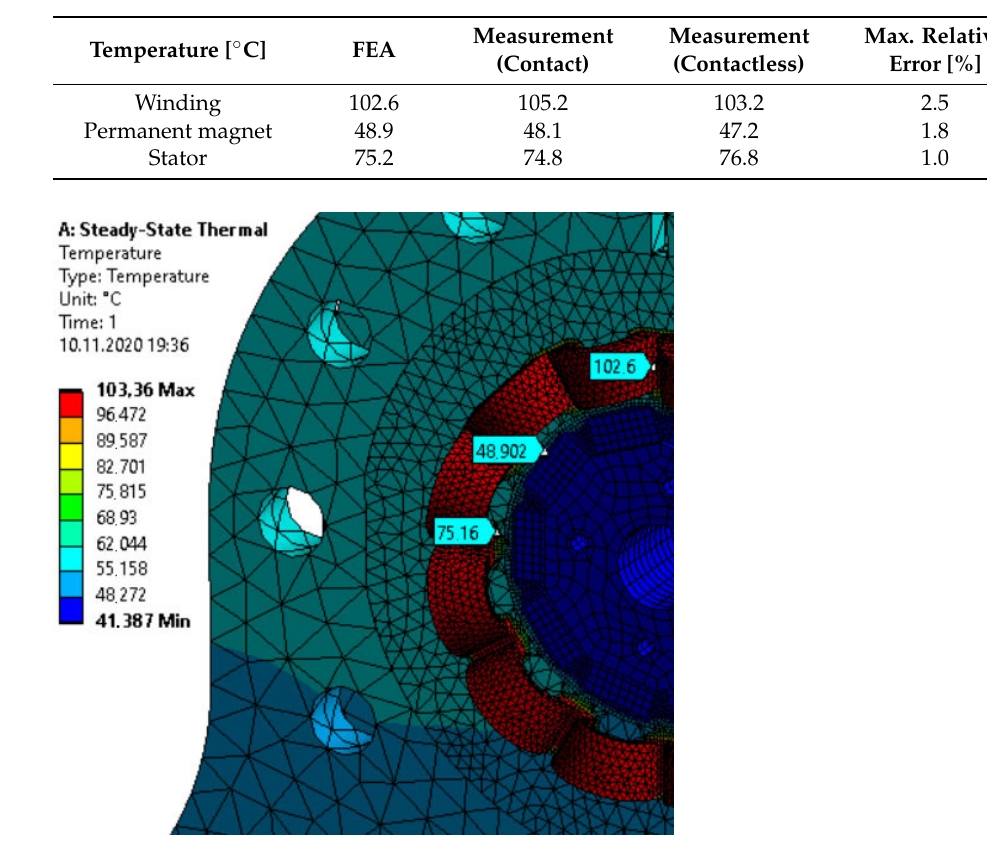
Figure 15. FEA simulation results of the obtained equivalent conductivity coefficient—rotating